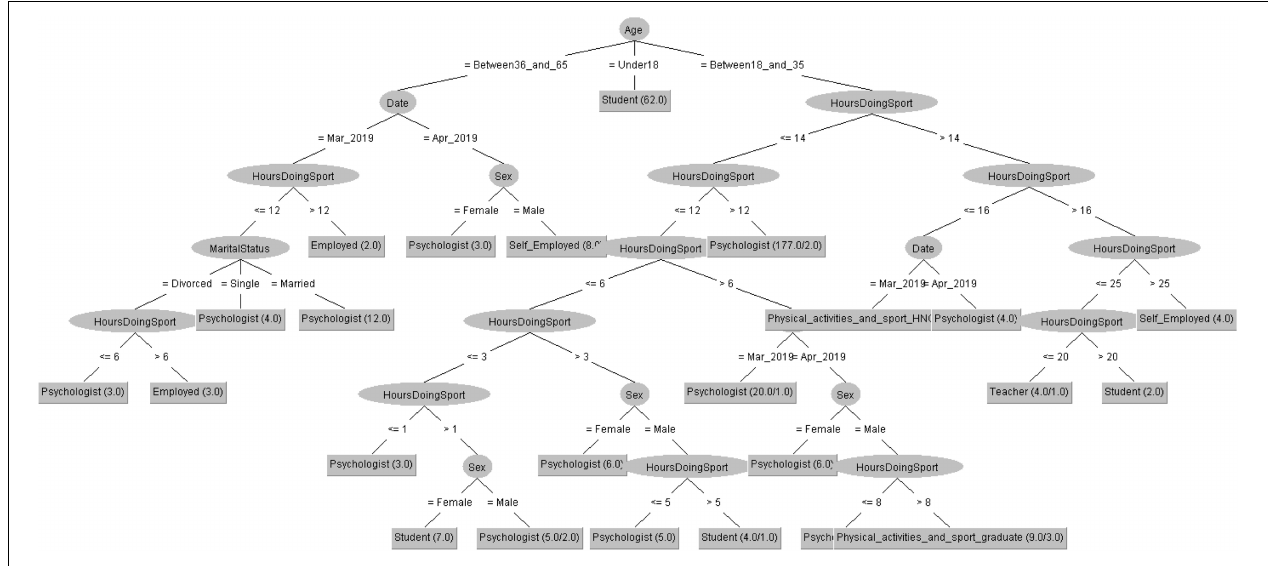
FIGURE 5 | Profession of people taking the CSAI-2 questionnaire in 2019 decision